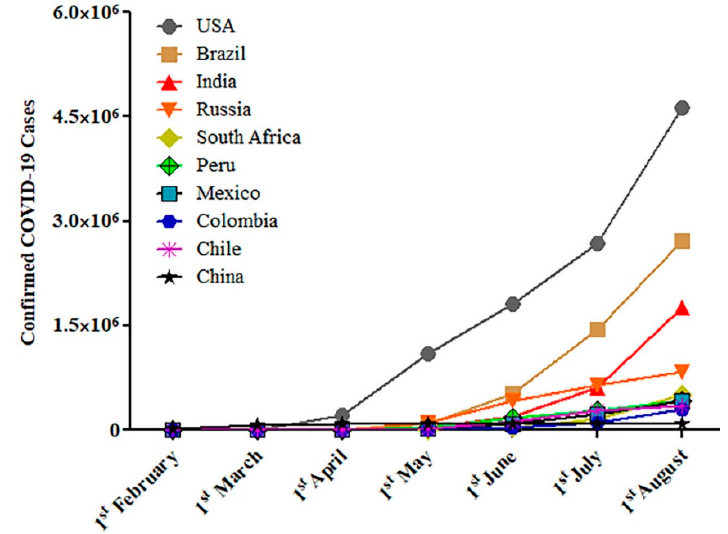
Figure 1. Reported confirmed COVID-19 cases over time in top ten highly infected countries.